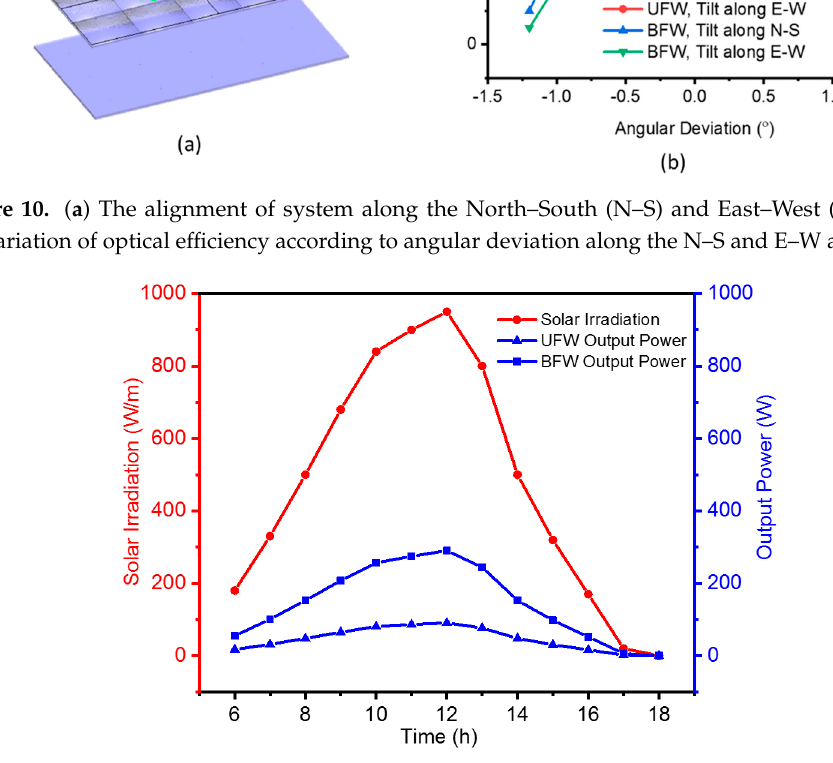
Figure 11. Solar irradiation and electrical output power of the UFW and BFW over time on a summer’s day.